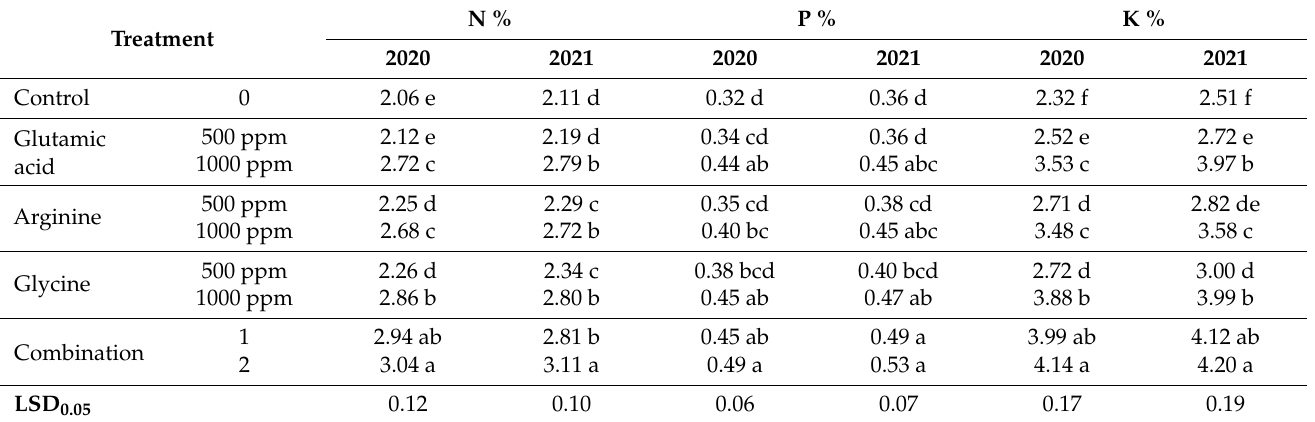
Table 6. The influence of glutamic acid, arginine, and glycine amino acids on the leaf content from N, P, and K of guava during the 2020 and 2021